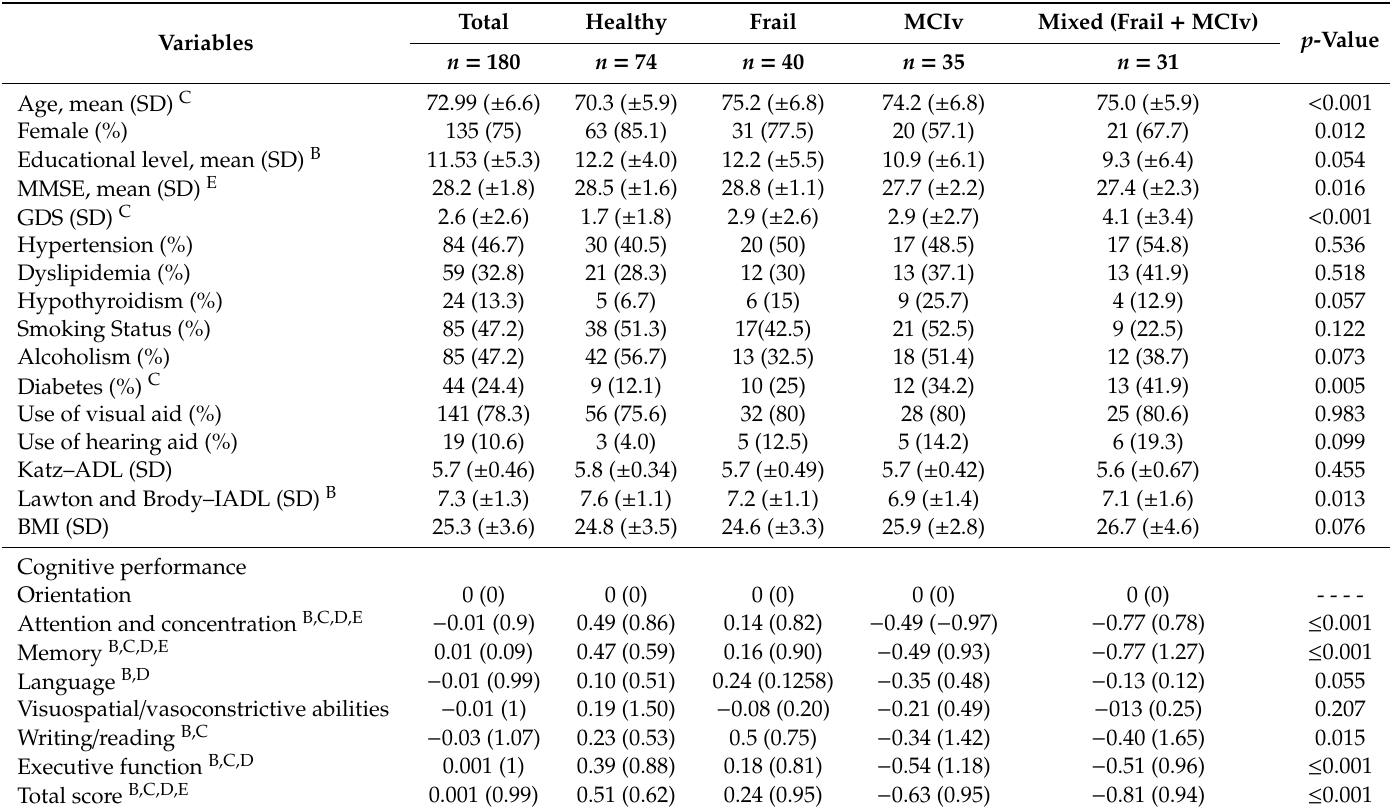
Table 1. Sociodemographic characteristics, clinical status, and cognitive performance of the study